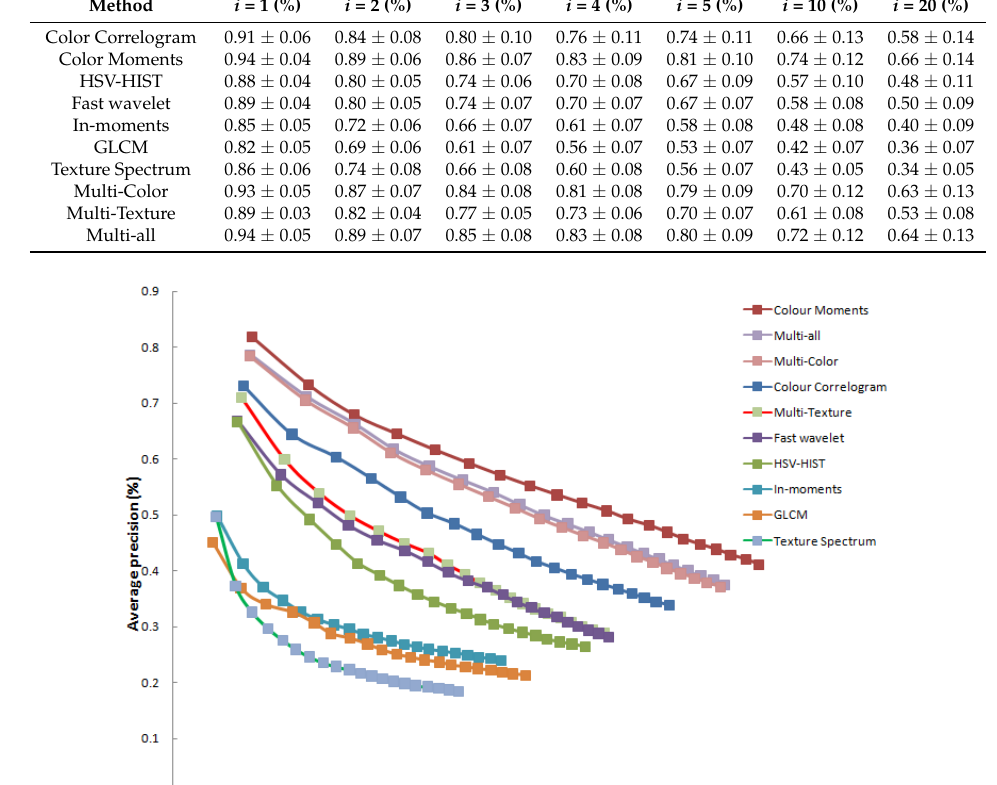
Table 4. Comparison of different methods: Mean Average Precision value.